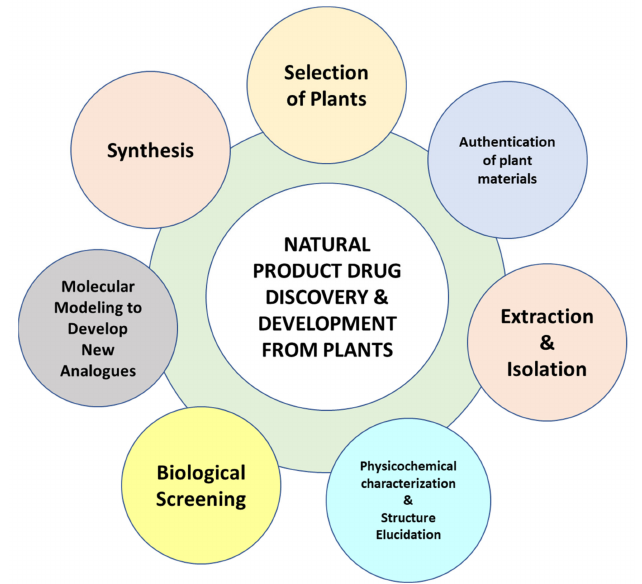
Figure 1. The major processes involved in the discovery and development of natural products from botanical